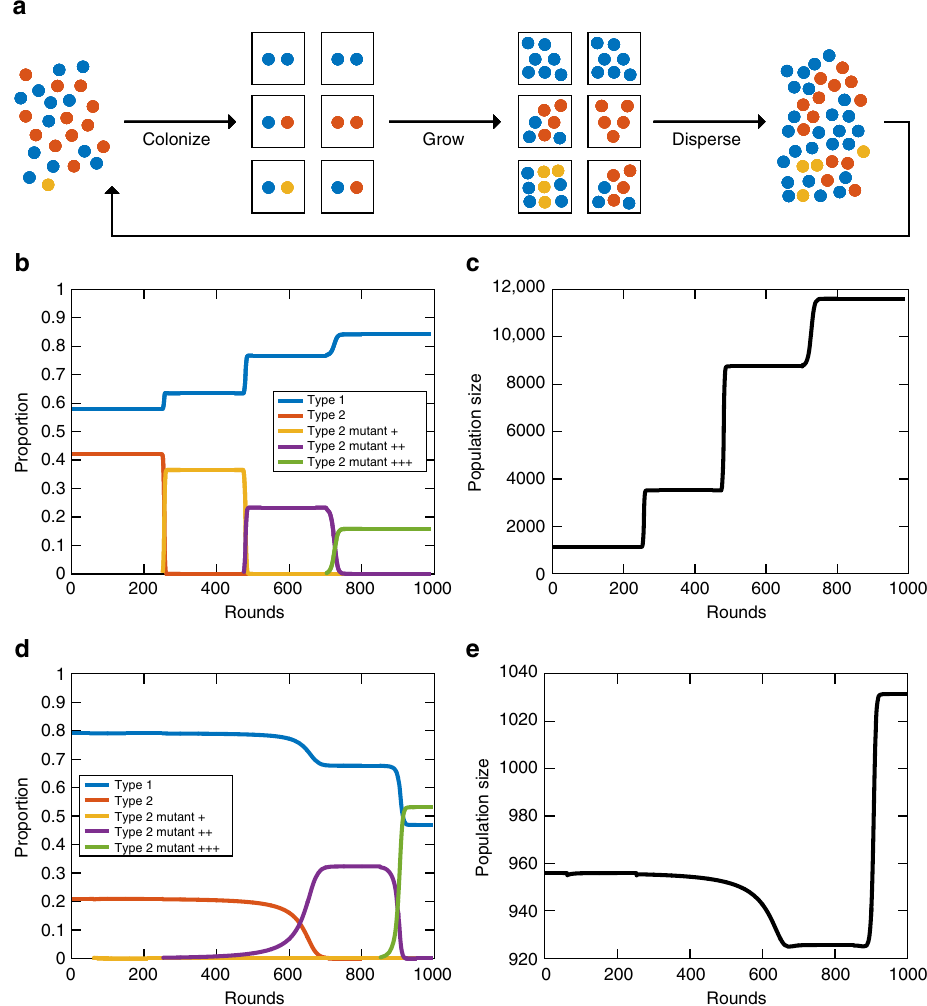
Fig. 6 Evolution of paradoxical behavior in a metapopulation model. a A schematic shows the structure of the metapopulation model. Each patch (box) is colonized by two cells that are potentially of the same type. The cells grow and reproduce in the patch for a fi xed amount of time and then, they are released to colonize new patches, thereby completing a “ round ” . The process is repeated until a steady state of relative frequencies is reached. b Paradox 1 is observed when cell type 2 mutants with increased a B ,2 invade. Each + indicates a mutant with an increased ef fi ciency over its ancestors such that the +++ mutant has the highest a B ,2 . In each case, the mutant successfully displaces its ancestor but reaches a lower fi nal proportion. c The population size corresponding to b shows that despite the lower proportion of the mutant, the growth rate (proportional to population size) is increasing. d An invasion by type 2 cell mutants with successively higher a A ,2 is shown. The fi rst mutant does not invade, but the second and third do. e The population size corresponding to d shows the occurrence of paradox 2 during the invasion of the ++ mutant. The population size decreases. Following the successful invasion of the +++ mutant, the population size increases beyond its initial starting